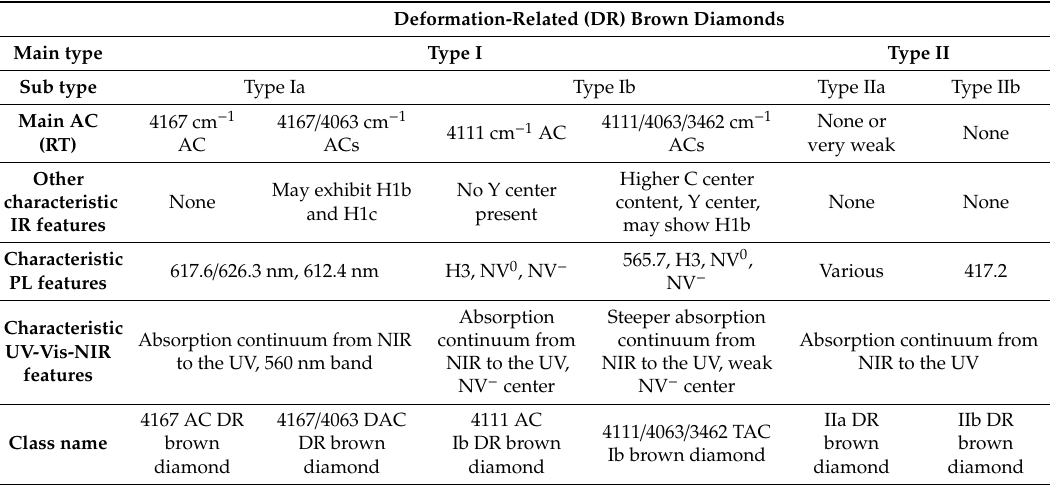
Table 4. The newly elaborated classification of natural, untreated DR brown